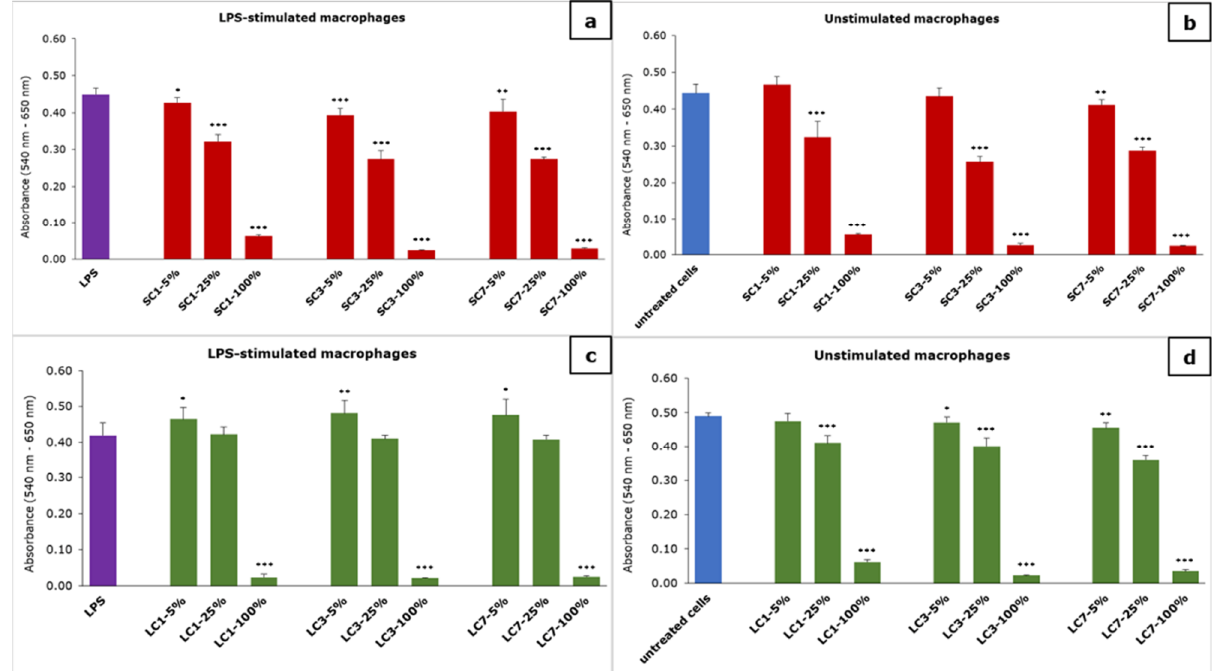
Figure 3. The effect of the material extracts on metabolic activity of macrophages: ( a ) effect of SC- material’s extract on LPS-stimulated macrophages, ( b ) effect of SC-material’s extract on unstimulated macrophages, ( c ) effect of LC-material’s extract on LPS-stimulated macrophages and ( d ) effect of LC-material’s extract on unstimulated macrophages; results are presented as mean ± SD (*) p < 0.05, (**) p < 0.01, (***) p < 0.001; SC—self-curing; LC—light-curing material.